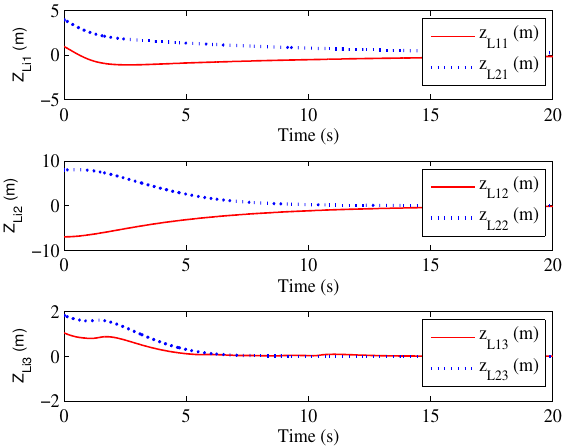
Figure 11. Positions of the leader and followers with the ASONTSMC method.